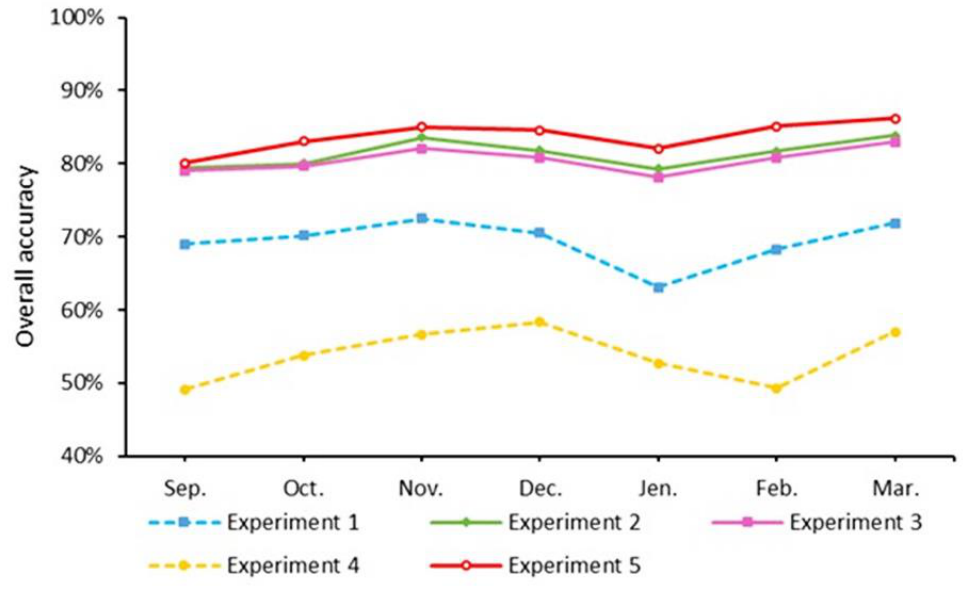
Figure 11. Classification accuracy as a function of experiments.